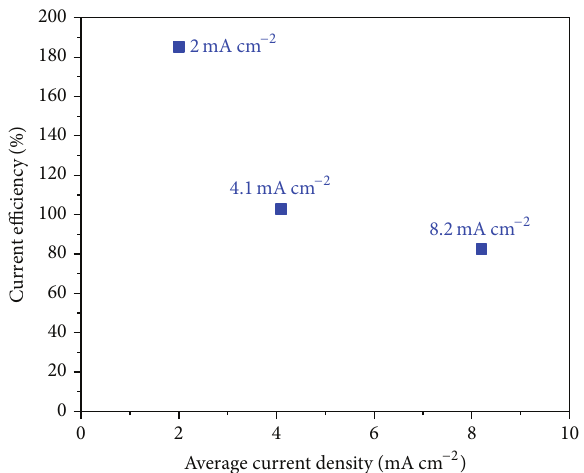
Figure 12: Plot of average current efficiency versus applied average current